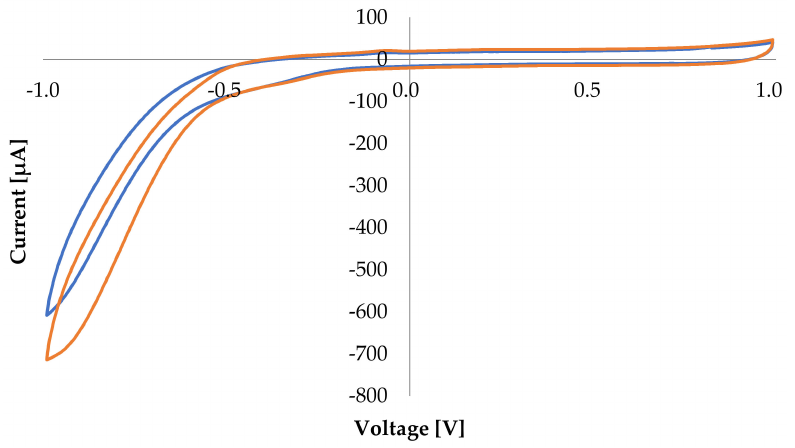
Figure 3. Cyclic voltammetry performed for Laccase biocathode in absence (blue line) and presence (red line) of air in NaOAc buffer solution (pH 5.0) at 20 mV s − 1 scan rate.